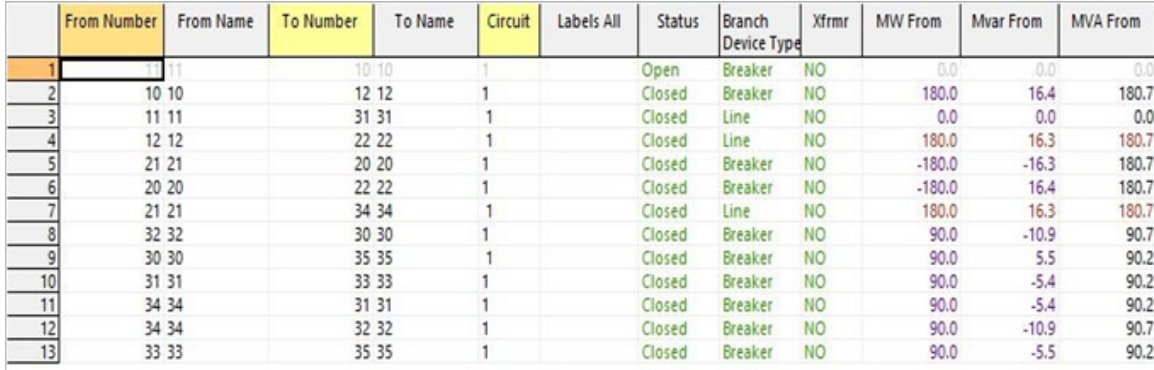
Figure 11. Measurement values of the transmission line under attack scenario IV.